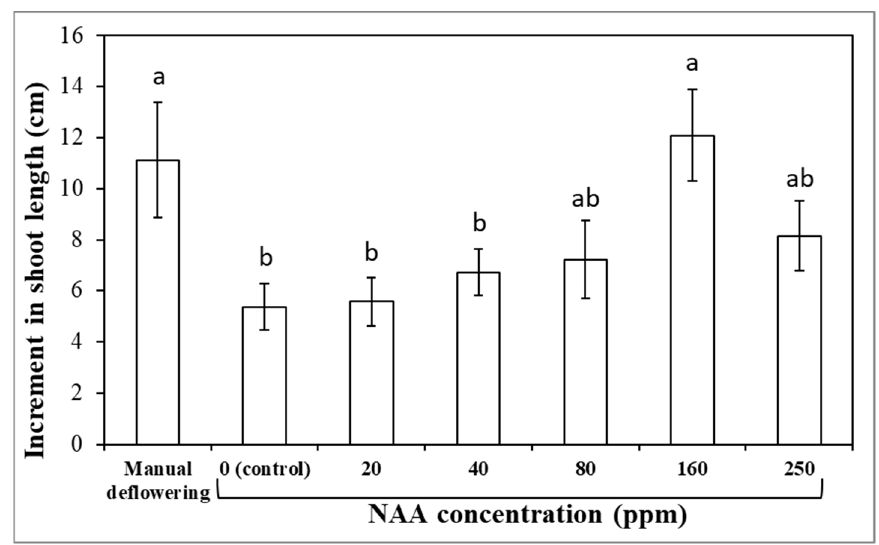
Figure 4. Increment of shoot length in control, different NAA concentrations, and manually deflowered trees in a young intensive olive orchard of the cultivar Moraiolo. Values are means of 16 replicates per treatment, and bars represent standard errors. Different letters indicate significant differences between treatments according to the Student–Newman–Keuls Test ( p < 0.05).